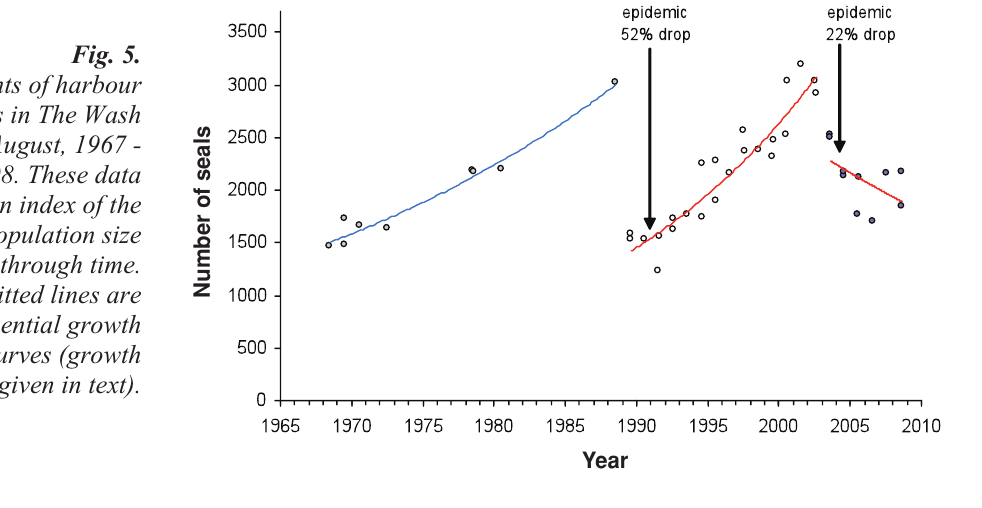
The number of harbour seals count- ed in the Firth of Tay, between 1990 and 2008.